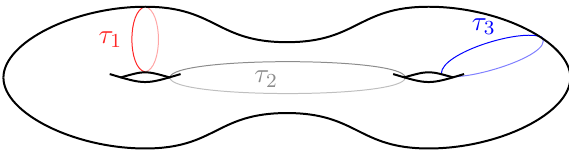
Figure 1 . Genus-2 surface with three different cycles related to the three moduli τ i